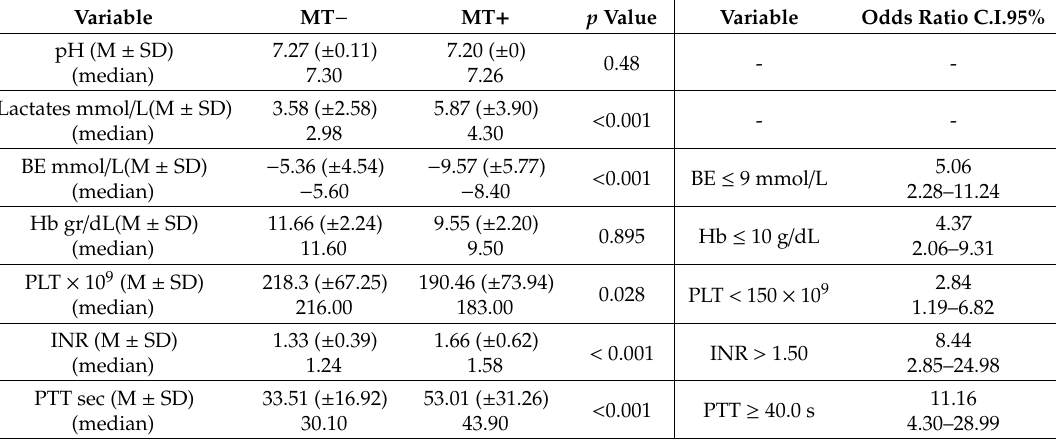
Table 2. Left: Laboratory parameters and types of injuries in patients of Milano Trauma registry. Right: variables significantly associated with MT at univariate